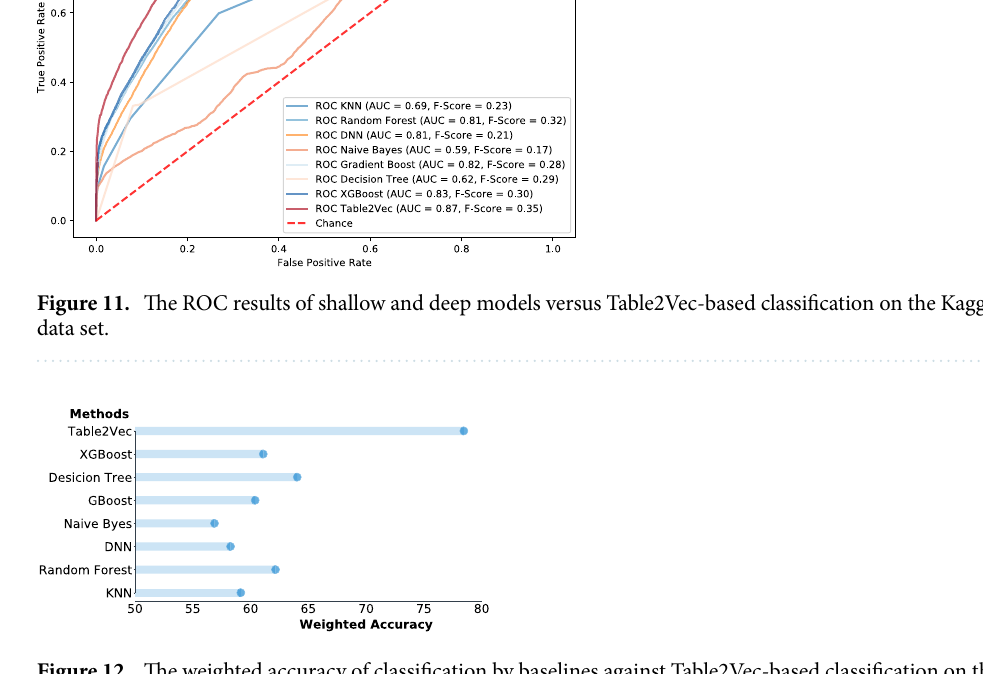
Figure 12. The weighted accuracy of classification by baselines against Table2Vec-based classification on the Kaggle data set.